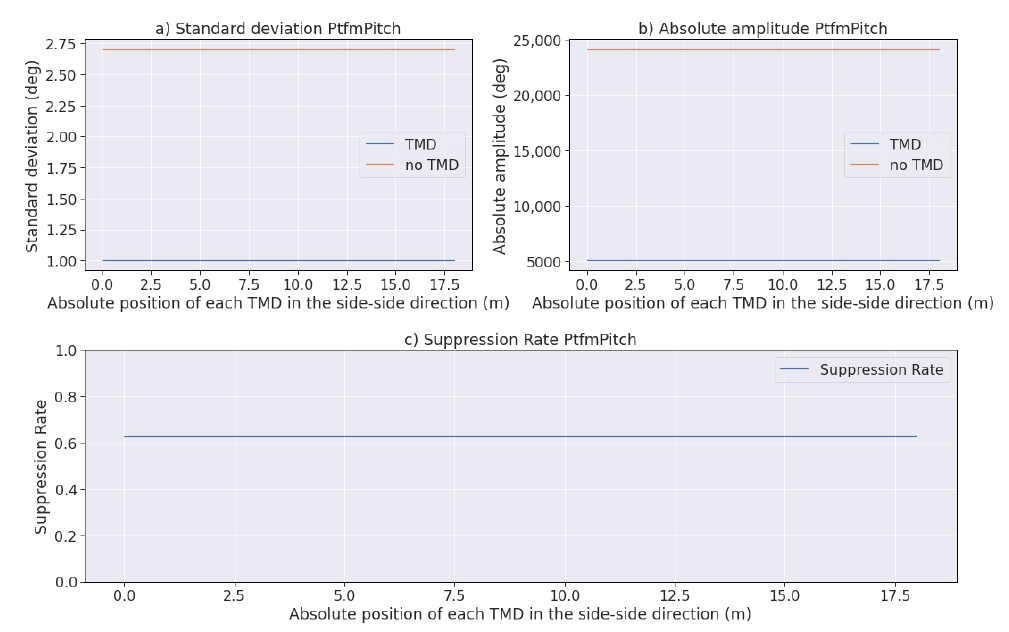
Figure 13. Results when moving two TMDs in the side-side direction keeping the same distance to the center. ( a ) Sum of PtfmPitch standard deviation; ( b ) Sum of PtfmPitch amplitude; ( c ) PtfmPitch suppression